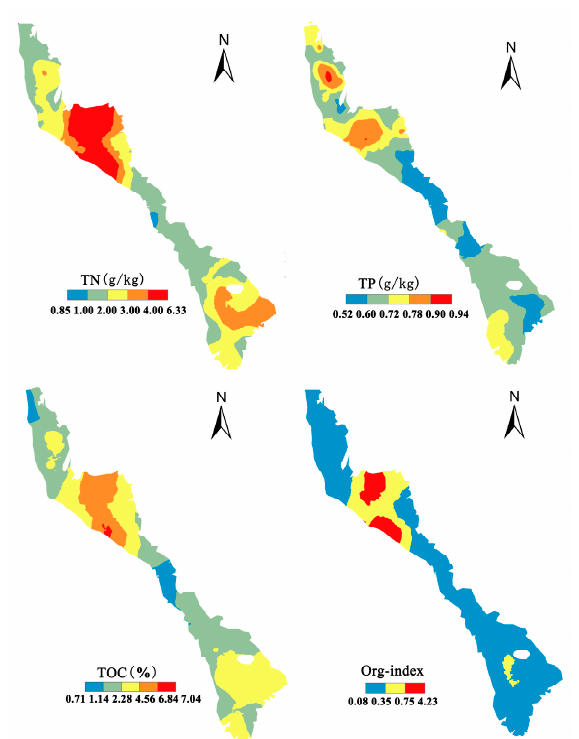
Figure 3. The geochemical map of nutrients and its organic pollution evaluation index in the surface sediments of Nansi Lake.